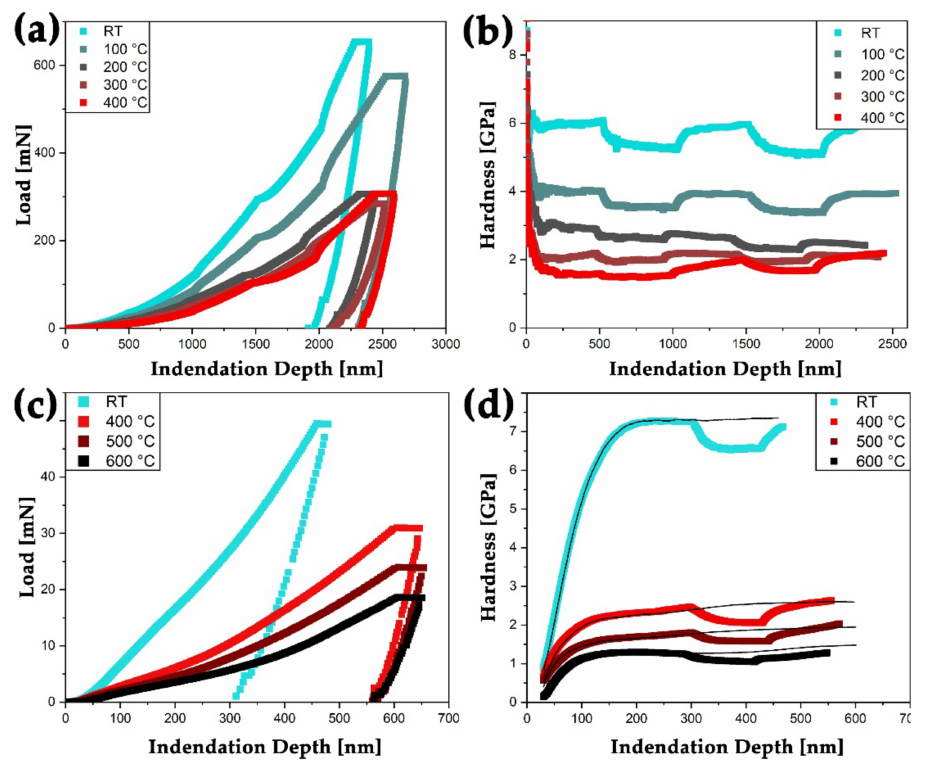
Figure 3. Representative indentation data of nc W/Cu specimen from indentation experiments gathered by the G200 setup ( a , b ) and the InSEM-HT nanoindentation testing setup( c , d ). In ( a ) typical load and in ( c ) hardness vs. indentation depth curves at RT, 100, 200, 300 and 400 ◦ C are displayed. In ( c ) load and ( d ) hardness values are displayed over indentation depth for testing temperatures at RT, 400, 500, and 600 ◦ C, respectively. Within an indentation depth of 300 to 425 nm the constant strain rate was decreased from 0.4 to 0.04 s − 1 for strain rate jump tests at the same temperatures. Additional indentation experiments with a constant strain rate were performed for comparison and are displayed as black lines in ( d ). For a colored representation, the reader is referred to the web version of this